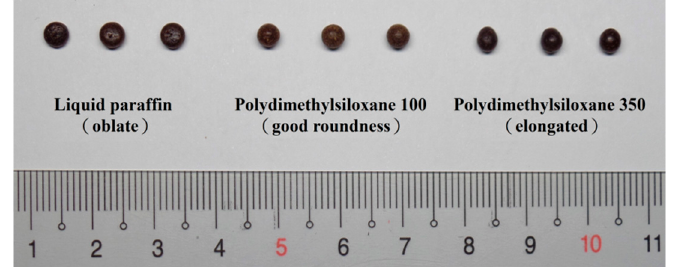
Figure 3 . Dropping pills prepared using different types of condensate.